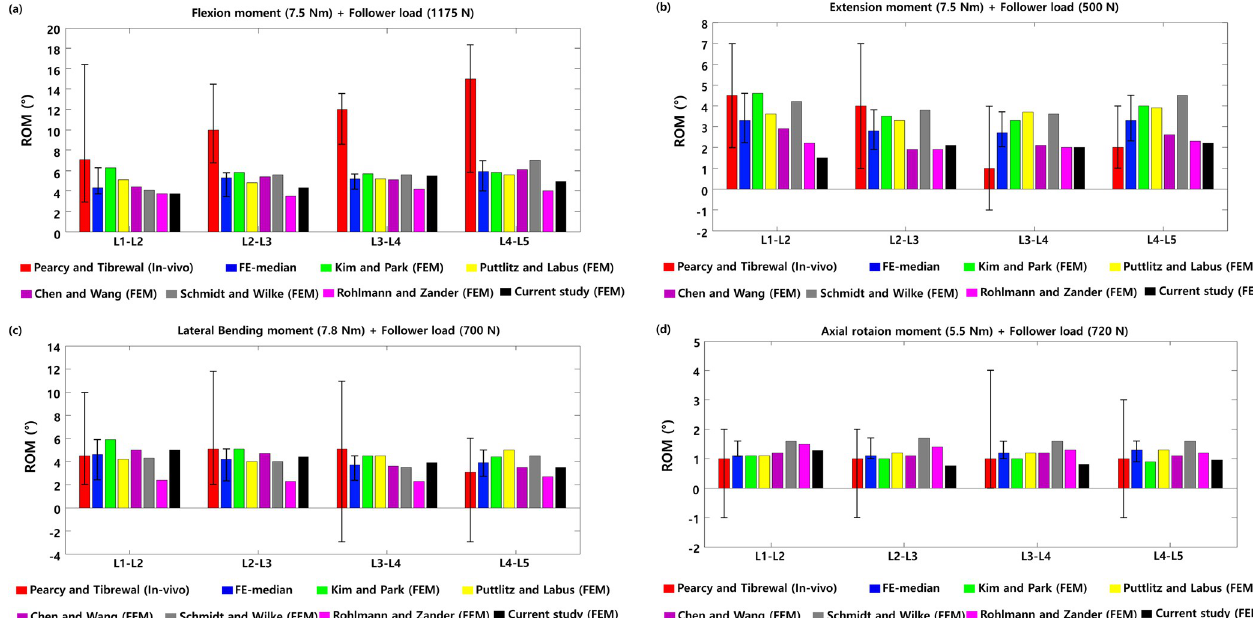
Fig 4. Range of motions (ROM) between two healthy lumbar spine segments was measured under a combination of (a) flexion moment (7.5 N � m) and follower load (1175 N), (b) extension moment (7.5 N � m) and follower load (500 N), (c) lateral bending moment (7.8 N � m) and follower load (700 N), and (d) axial rotation moment (5.5 N � m) and follower load (720 N) (The red bar is the median value of previous in vivo experimental findings, and other bars represent previous and current findings obtained from finite element analyses).